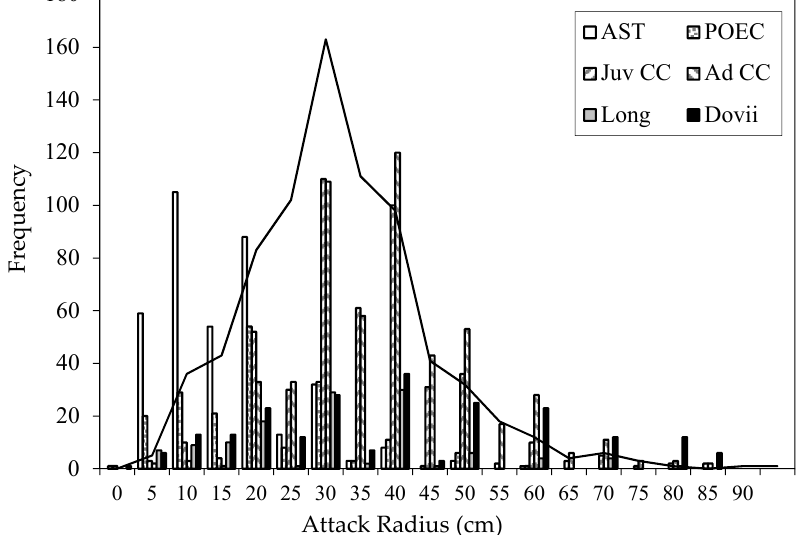
Figure 6. Parental brood defense attacks per 10 min observation period ( n = 840 trials) against the characin Astyanax fasciatus (AST), Poecilia gillii (POEC), juvenile convict cichlids (Juv CC), adult convict cichlids (Ad CC), sand-sifter cichlid Cribroheros longimanus (Long), or juveniles of the piscivore Parachromis dovii (Dovii). Line represents overall frequency distribution of parental attacks against brood predators. Data from [10,17].